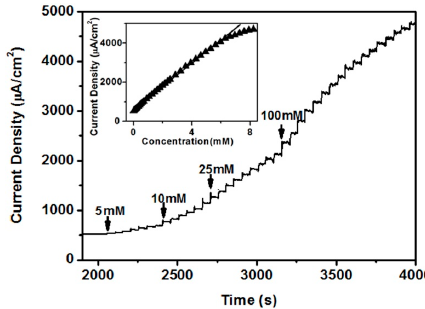
Figure 9. Amperometric response of CeO 2 /Ni(OH) 2 /CPE measured at 0.55 V in 0.1 M NaOH solution with successive addition of glucose. Inset is the plot of current response with glucose concentration. Table 1. Comparison of performance obtained from different glucose biosensors.